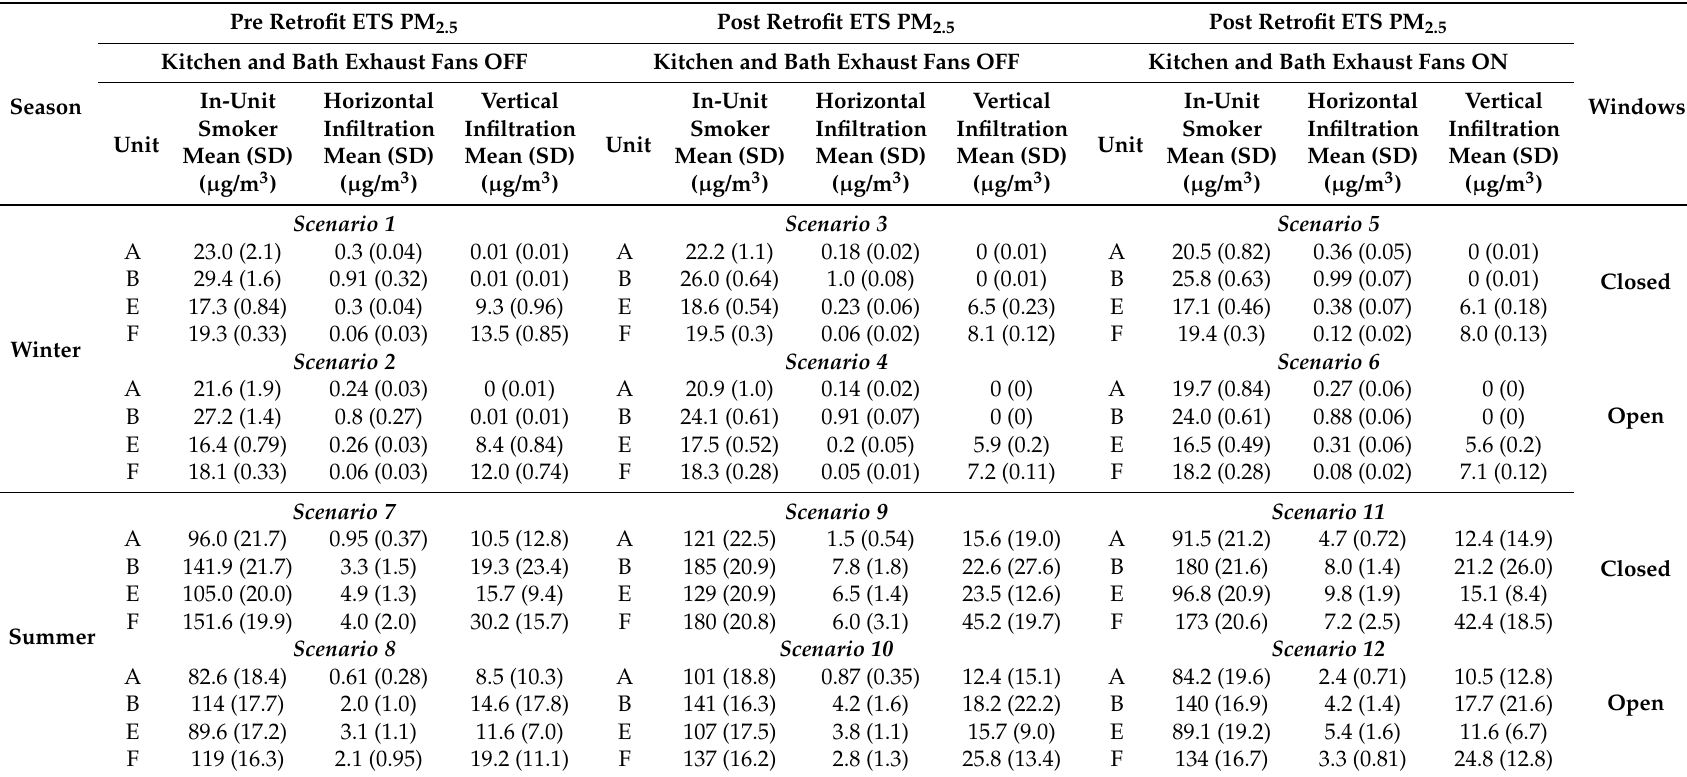
Table 2. Predicted mean twenty-four hour average ETS PM 2.5 concentrations generated by the smoker in each unit as well as the ETS PM 2.5 concentration infiltrating from apartments located adjacent horizontally (right or left) and vertically (above or below). Results are stratified across all factors modeled (pre/post retrofit, window opening, exhaust fan use, season). Exhaust fans are only operated in units A and